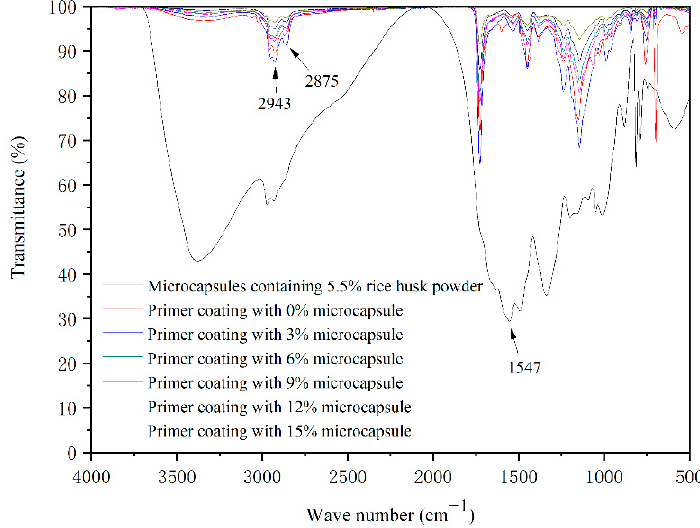
Figure 10. Infrared spectrum of waterborne primer with different contents of microcapsules.